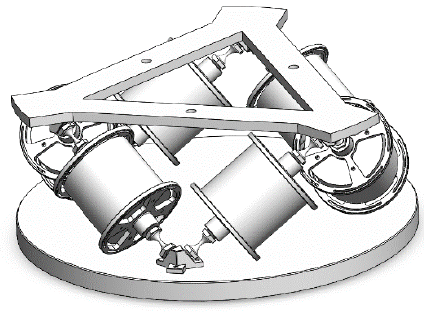
Figure 1. The composition of the platform.